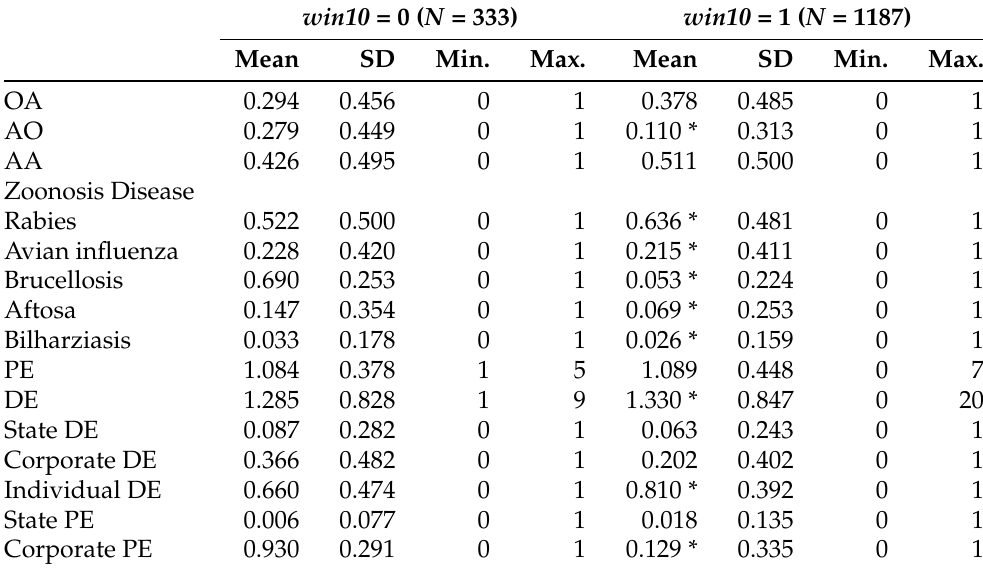
Table 5. Descriptive statistics of the judged case observations grouped by win10